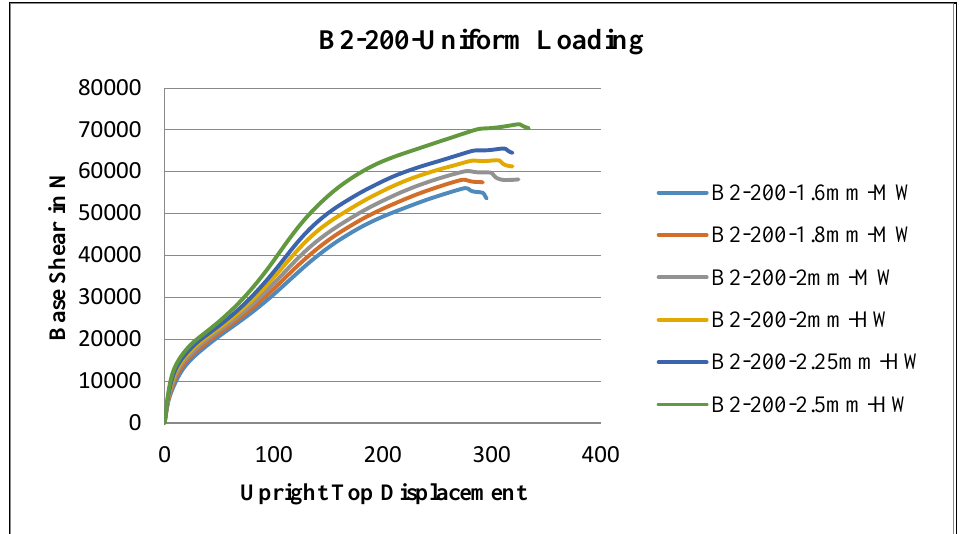
Fig. 15. Base shear versus upright top displacement for B2-200 (UBC-1997)